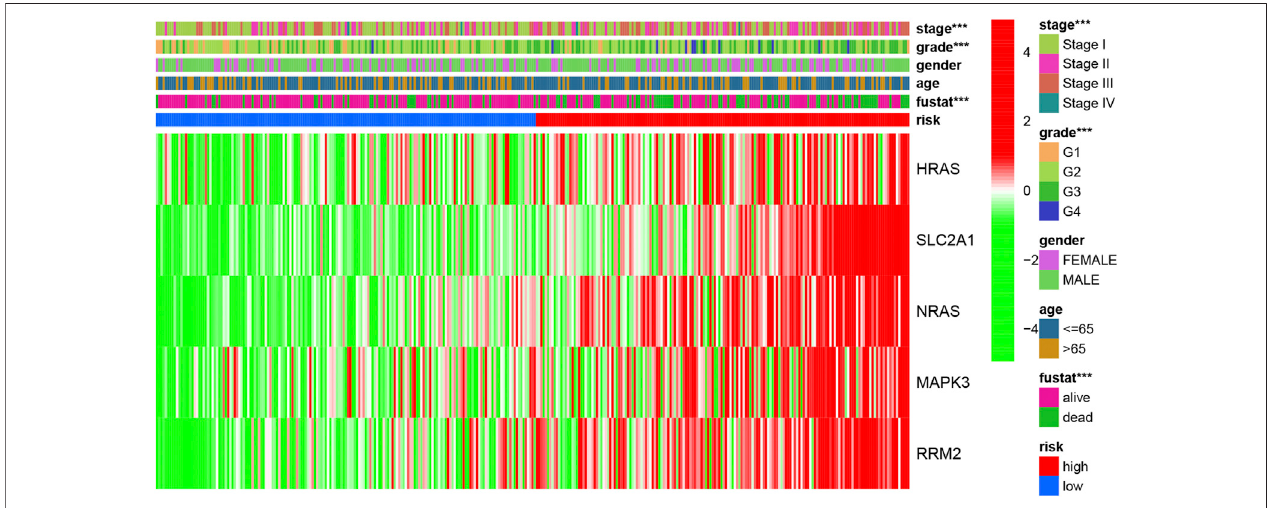
FIGURE 5 | The heatmap of clinicopathological features and ferroptosis-related hub gene expression in two risk subgroups.